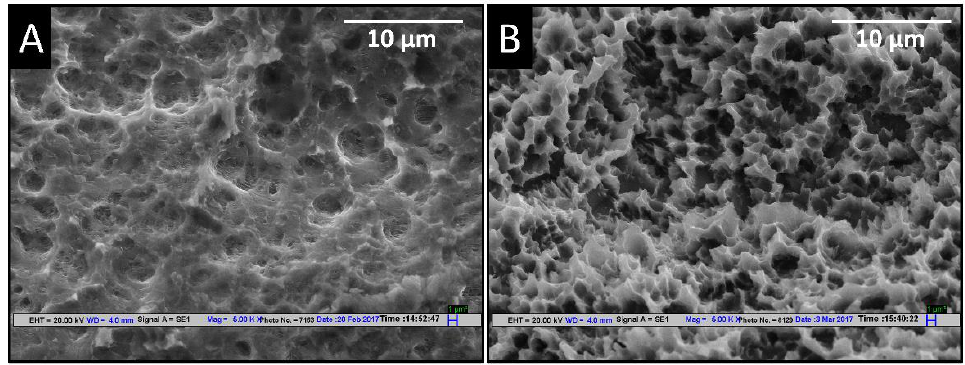
Figure 6. Comparative SEM images of ( A ) SLA surface of Ti6Al4V ELI grade alloy etched at 80 °C for 5 min and ( B ) SLA surface of Neobiotech commercial dental implant.